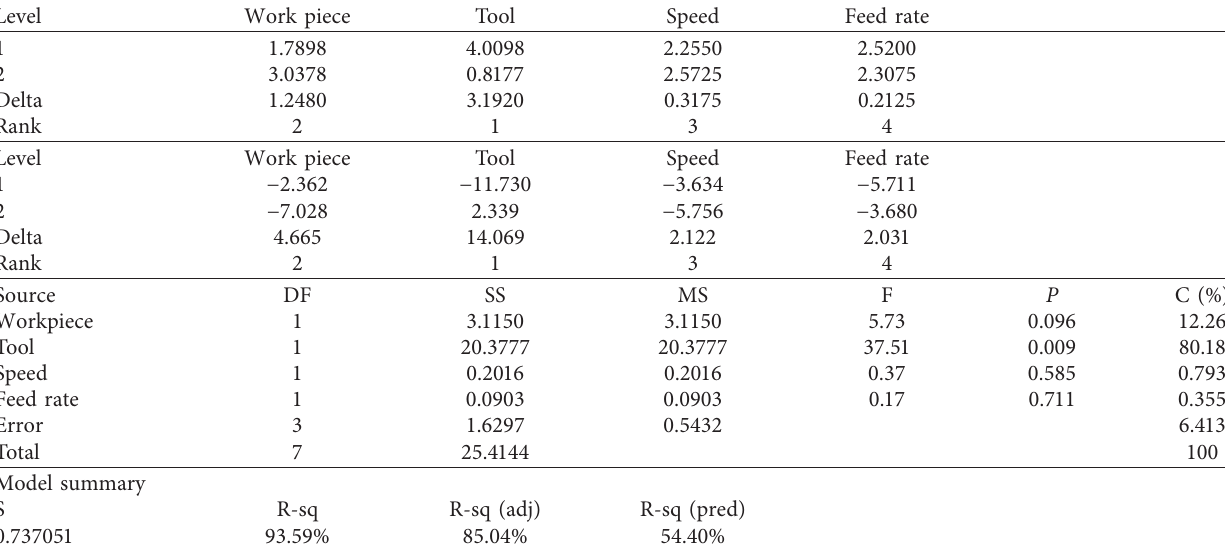
Table 4: (a) Response table for means and signal to noise ratios; (b) regression analysis (ANOVA) by genetic linear model on